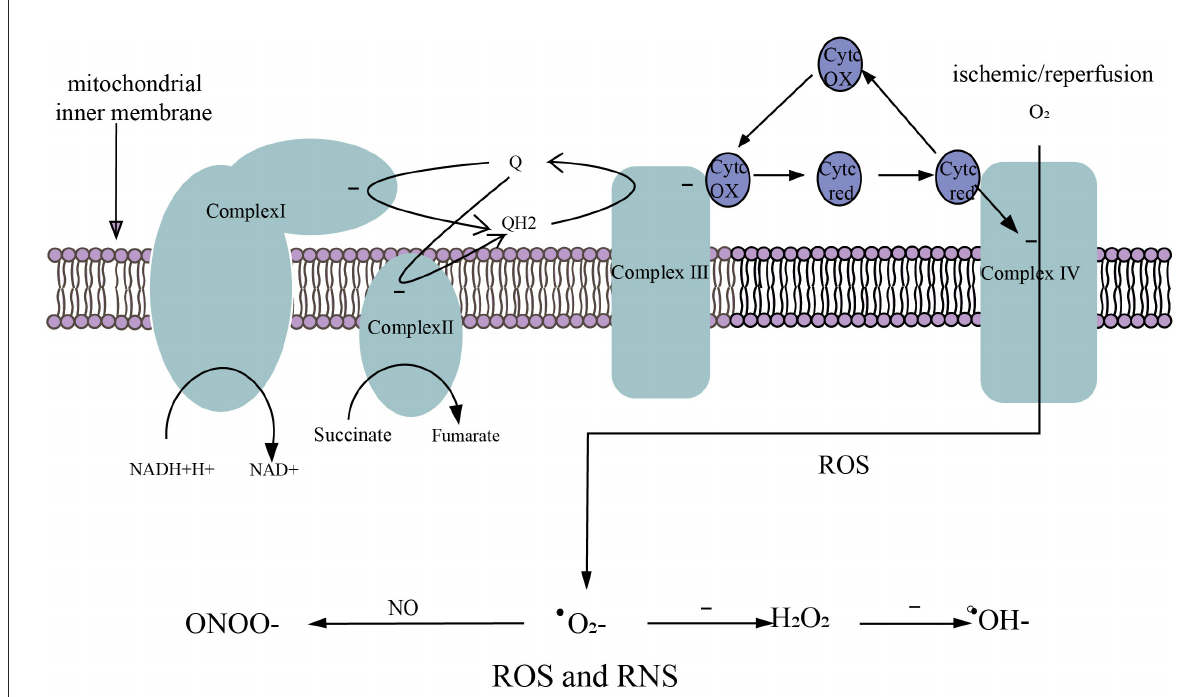
FIGURE3 Generation of ROS and RNS. (1) NADH oxidation respiratory chain. NADH-H + transfers electrons to complex I and is oxidized to NAD + . (2) Succinate oxidation respiratory chain. Succinate transfers electrons to complex II and is oxidized to fumarate. (3) The electrons in complex I/II are captured by ubiquinone (Q) to form QH2. The electrons in QH2 are transferred to complex III, then QH2 that loses electrons becomes Q to participate in the electron transfer again. Electrons in complex III are transferred to complex IV via cytochrome c (Cytc). (4) O 2 obtains electrons from complex IV to generate ROS. (5) After ischemic/reperfusion injury, O 2 gets a single electron to generate superoxide anion ( . O − 2 ), . O − 2 accepts a single electron to generate hydrogen peroxide (H 2 O 2 ), and H 2 O 2 accepts a single electron to be reduced to hydroxyl radical ( . OH − ), − . O − 2 can rapidly oxidize NO to produce nitrite (ONOO